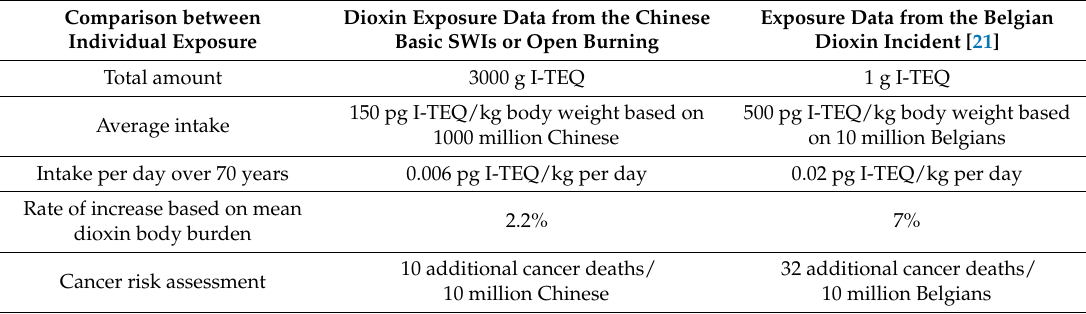
Figure 6. Emission factors from basic waste incineration (UNEP Toolkit), the current research incinerator, and open burning (UNEP Toolkit). Table 3. Comparison between individual exposure from the Chinese basic SWIs or open burning and that from a Belgian dioxin